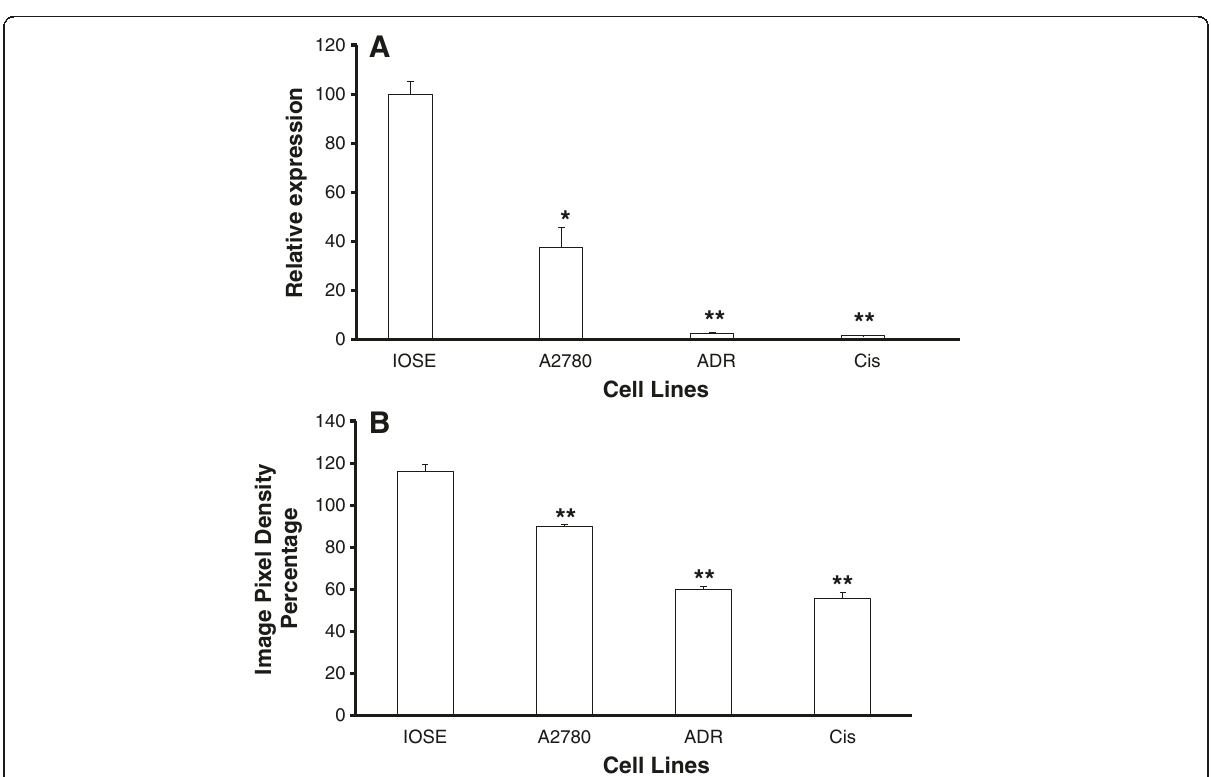
Figure 1 Comparison of quantitated sFRP4 expression across the four ovarian cell lines. The expression of sFRP4 in cancerous cell lines was compared to IOSE (normal) ovarian cell line. ( A ) sFRP4 mRNA expression across four cell lines. ( B ) sFRP4 protein expression across four cell lines. Values represent means for each group ± SEM (*p < 0.05; ** p < 0.001; one way ANOVA and